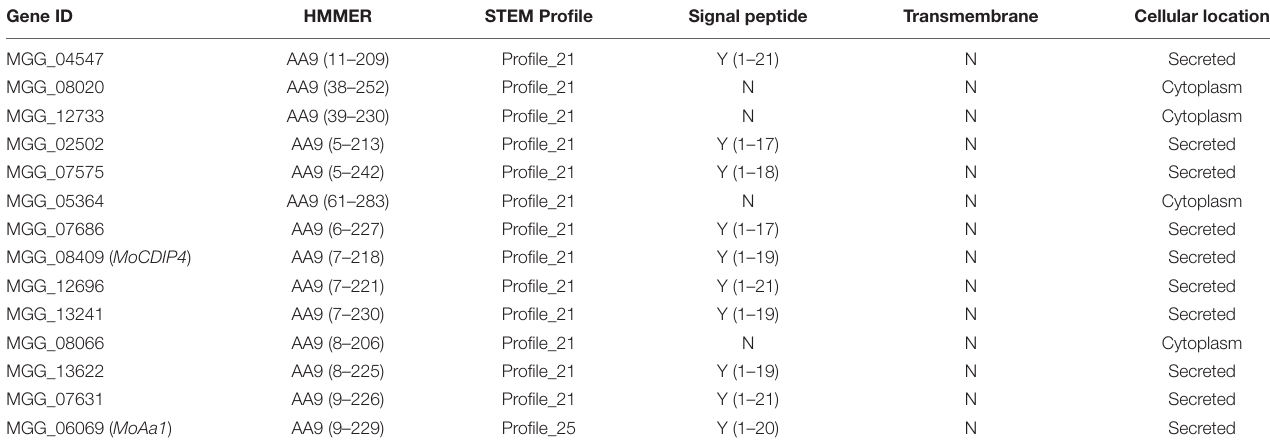
TABLE 5 | M. oryzae AA9 genes in CDEGs list. Gene ID HMMER STEM Profile Signal